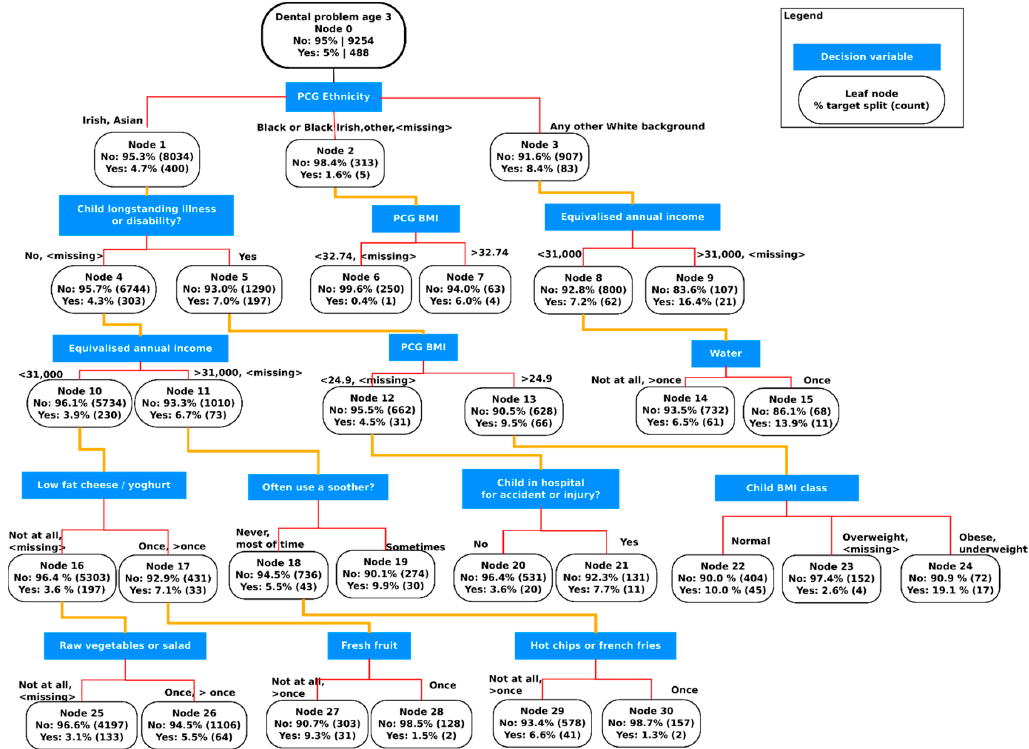
Figure 2. Prevalence of reported dental problems by the Growing Up in Ireland infant cohort at 3-years of age among classification tree subgroups, percentage (%) and number ( n ) in each class.